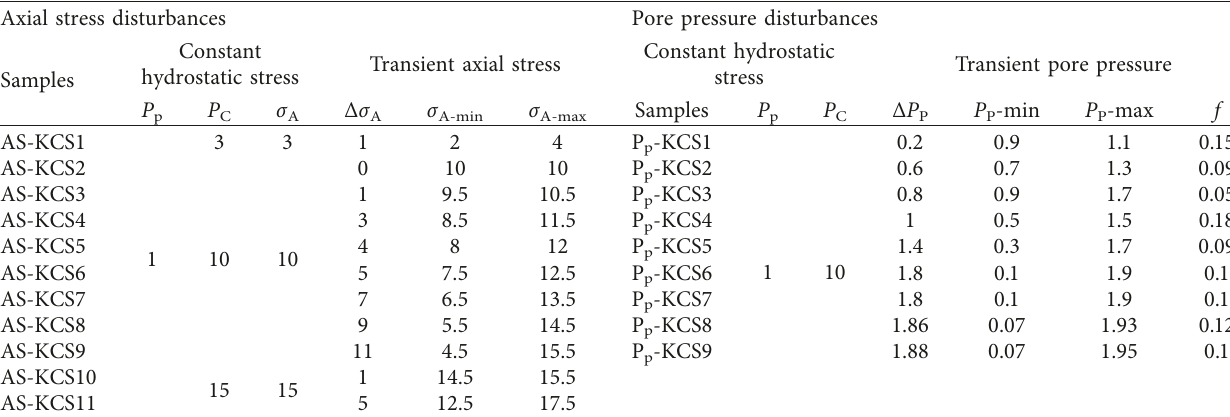
Table 4: Experimental conditions for the Kushiro Cretaceous sandstone.